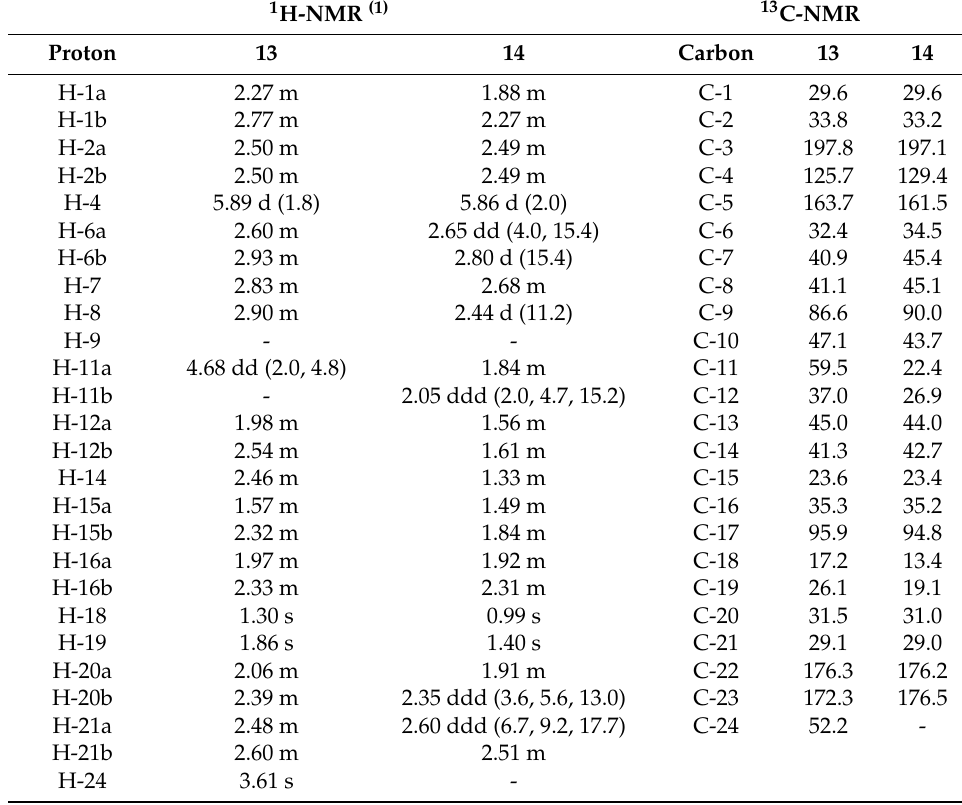
Table 7. The 1 H- and 13 C-NMR spectral data in CDCl 3 for (7 α ,11 β ,17 α )-9,11-dichloro derivative 13 and 7 α ,9:21,17-dicarbolactone 14